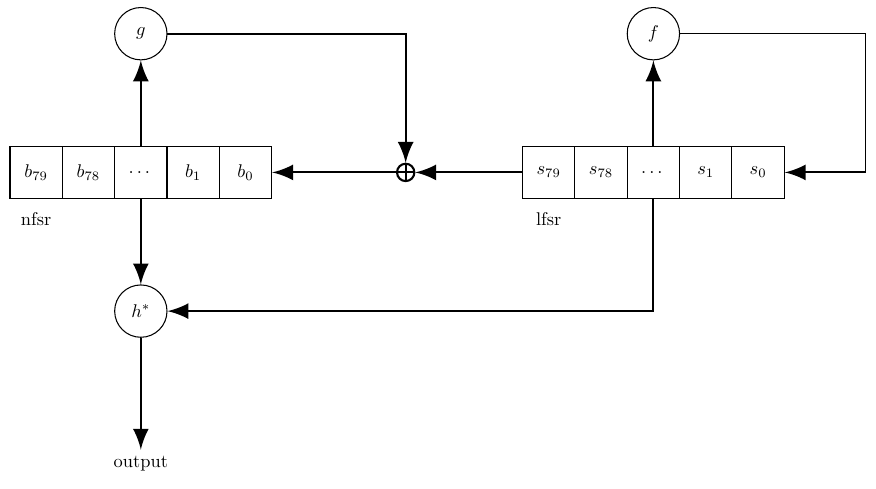
Figure 3: Simple representation of the grain v1